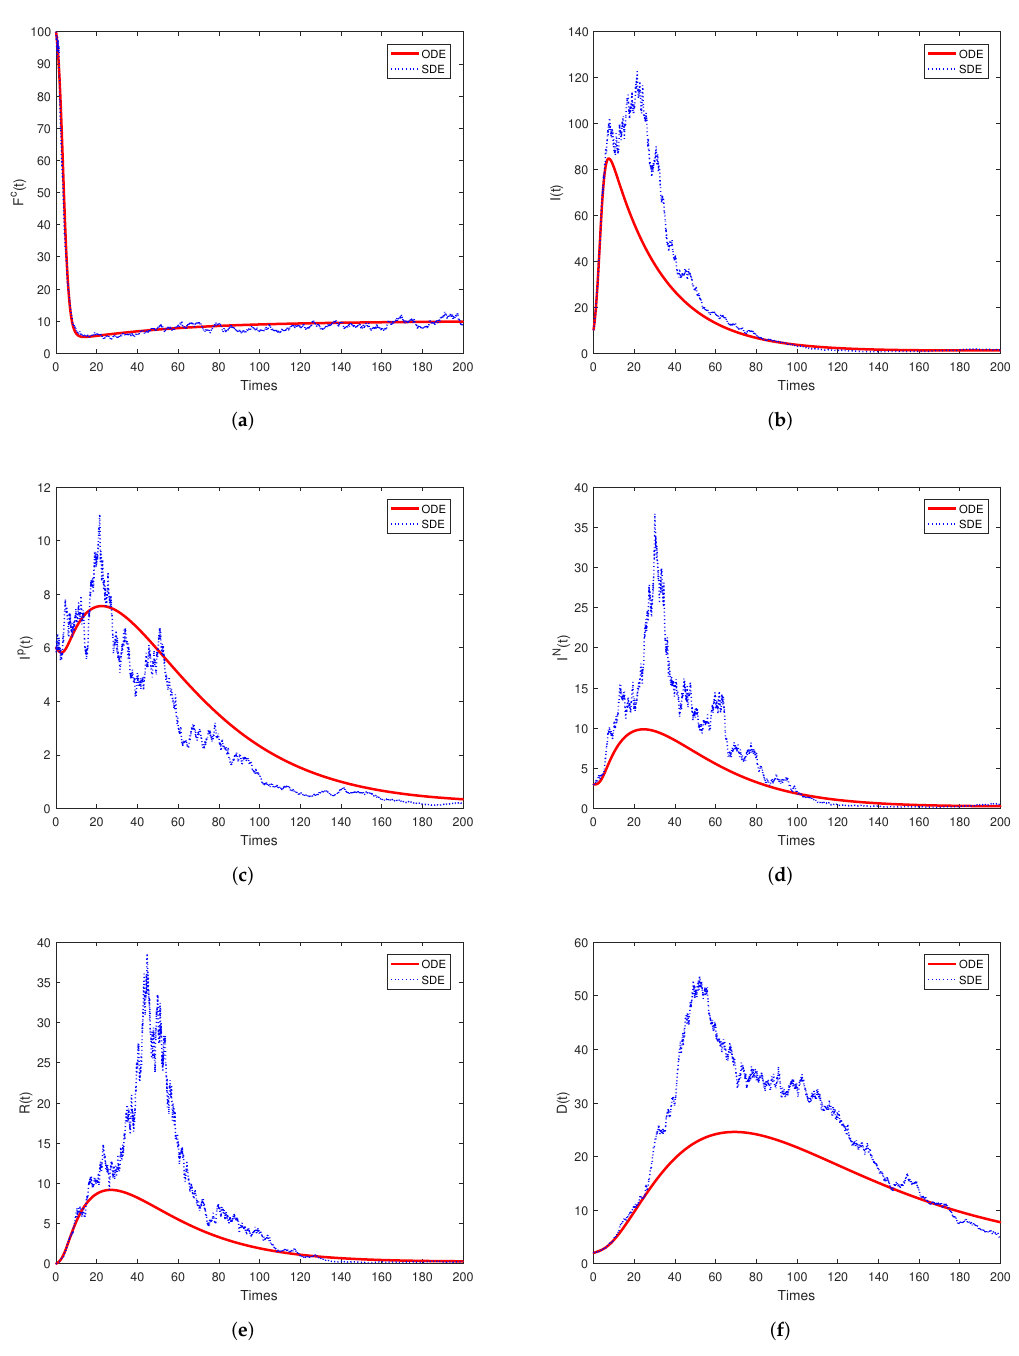
Figure 1. Simulations of ( F c ( t ) , I ( t ) , I P ( t ) , I N ( t ) , R ( t ) , D ( t )) for the stochastic model (1) with its corresponding deterministic version. ( a ) F C ( t ) : researchers using fractional differential operators with non-singular kernels. ( b ) I ( t ) : researchers that have been affected by the harmful papers. ( c ) I P ( t ) : researchers that have been affected, but still have positive opinions about non-singular kernel derivatives. ( d ) I N ( t ) : researchers that have been affected and have negative opinions about non-singular kernel derivatives. ( e ) R ( t ) : researchers that have overcome divisive criticism. ( f ) D ( t ) : researchers that die, or